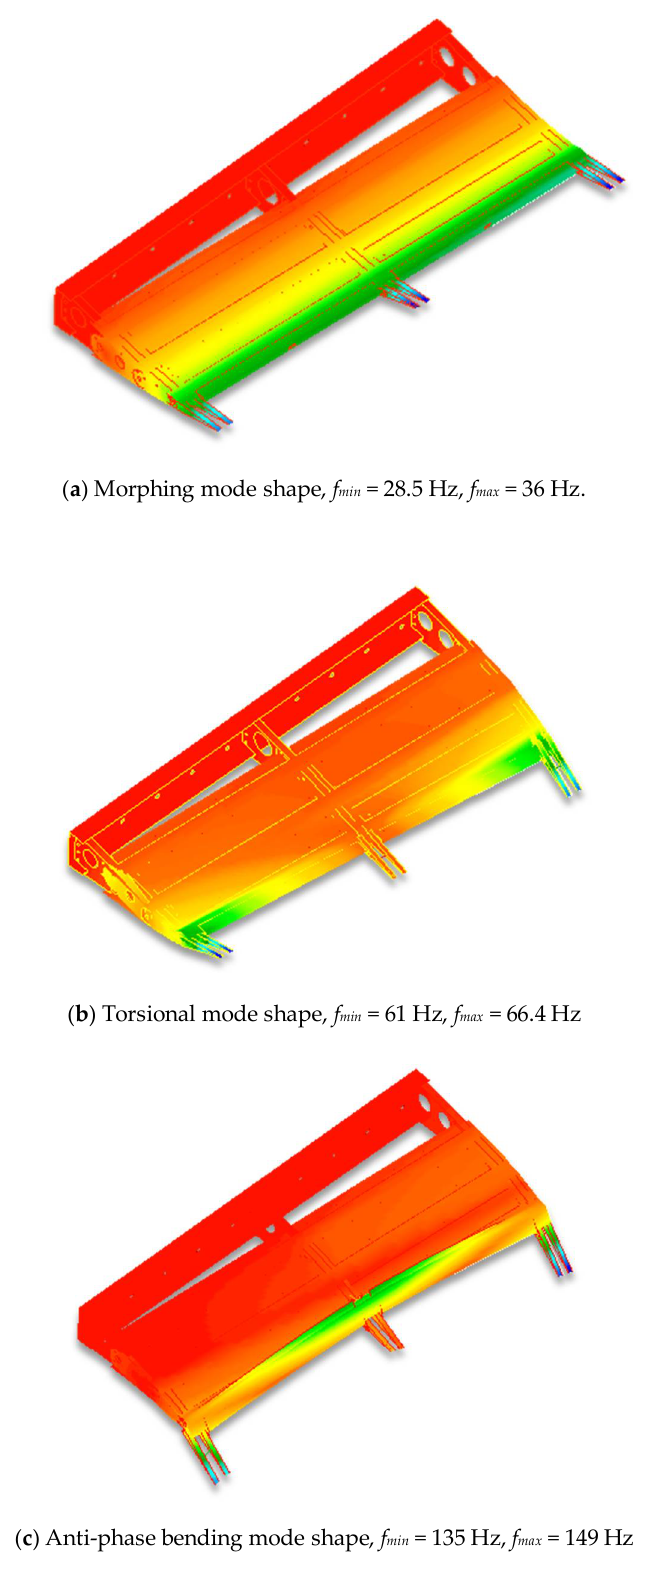
Figure 19. First three elastic mode shapes.